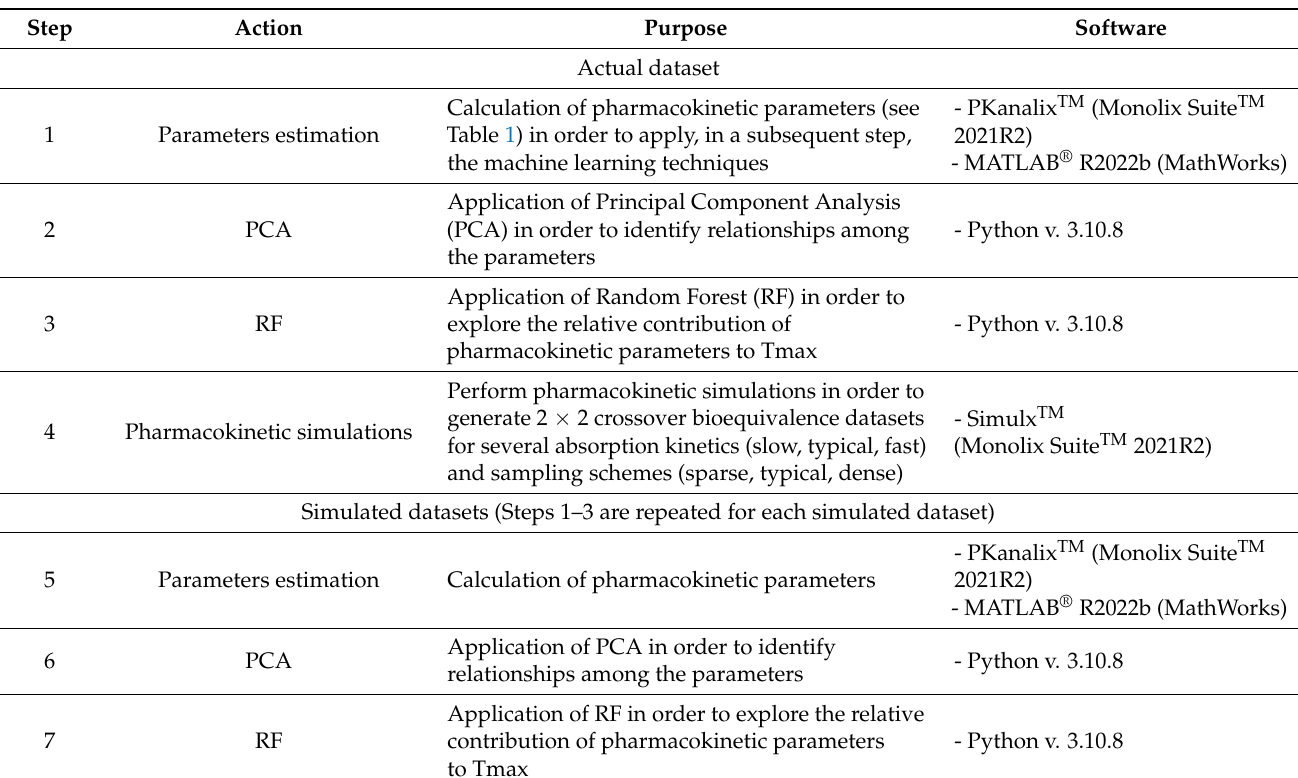
Table 3. A summarized outline of actions, their purposes, and the software used for their